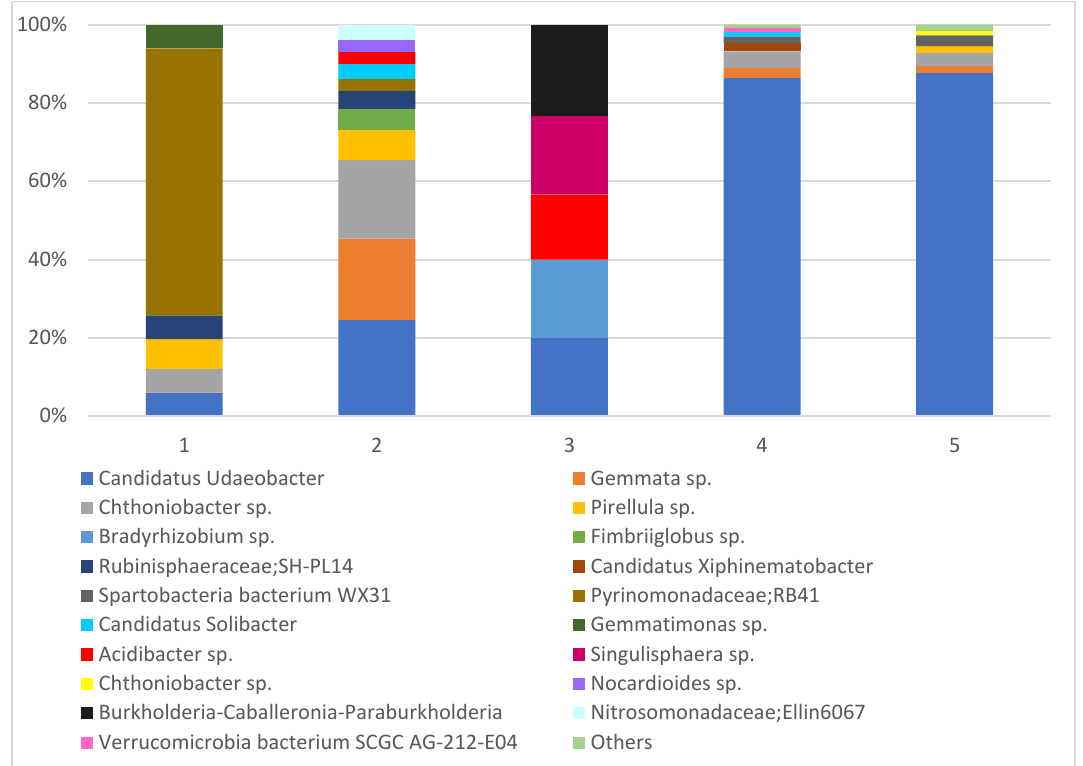
Figure 5. Bacterial communities detected in the surrounding soil of orchids. (1) E. atrorubens (Dobšiná); (2) E. atrorubens (Jasenie); (3) P. bifolia (Jasenie); (4) E. pontica (Sirk); (5) C. longifolia (Sirk). Species, such as Candidatus solibacter, Bradyrhizobium sp., Burkholderia sp., Gemmatimonas sp., Fimbriiglobus sp., Flavobacterium sp., Pseudomonas sp., Sphingomonas sp., Pedobacter sp., and